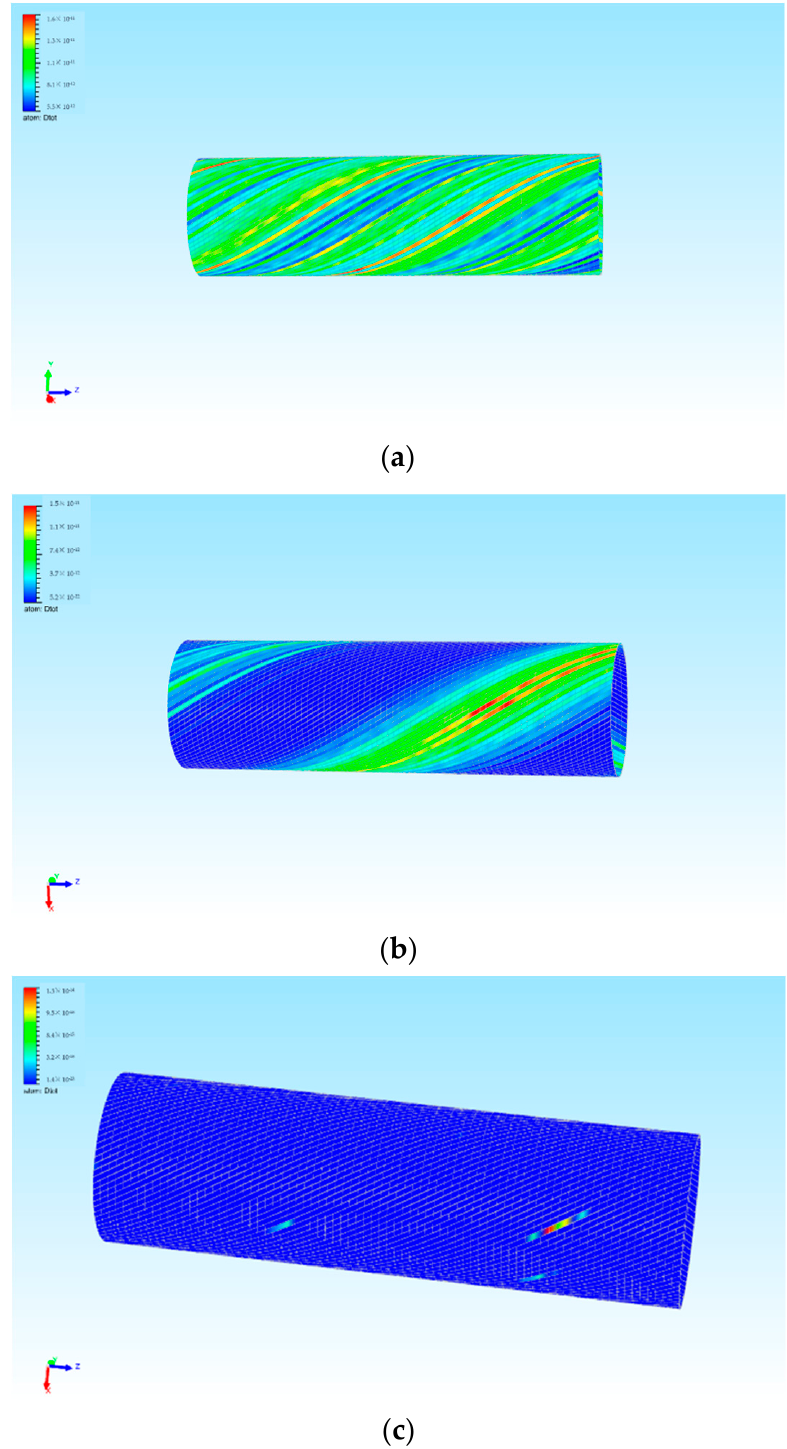
Figure 14. Fatigue damage of an external tensile armor layer. ( a ) The fatigue damage nephogram under axial compressive load; ( b ) The fatigue damage nephogram under bending moment; ( c ) The fatigue damage nephogram under torsion. The maximum fatigue damage under the three loads is shown in Table